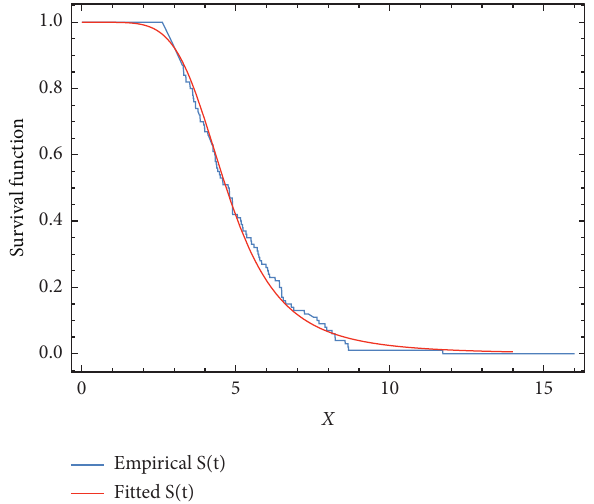
Figure 1: Empirical and fitted survival functions.